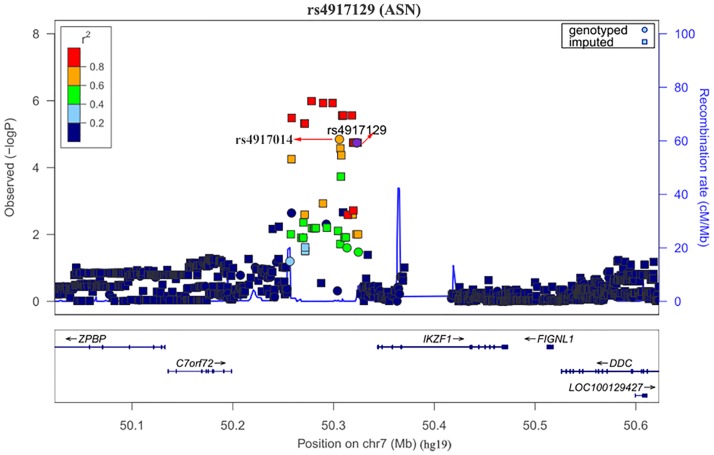
Regional association plot results for the primary Sjögren’s syndrome susceptibility locus near IKZF1.The plot shows the association results for both the genotyped (diamonds) and imputed (circles) SNPs in the GWAS samples. The -log10 P-values (left y-axis) of the SNPs are presented according to their chromosomal positions (x-axis). Genetic recombination rates, which were estimated using all the HapMap2 Project samples, are represented by light-blue lines, and genes within the regions are shown in the bottom panel. SNP rs4917129 is depicted as the larger purple circle labeled with the rs number, and its LD (r2 based on ASN data from the 1000 Genomes Project, November 2014) with the remaining SNPs is characterized by different colors. The position of rs4917014 is also labeled in the figure.